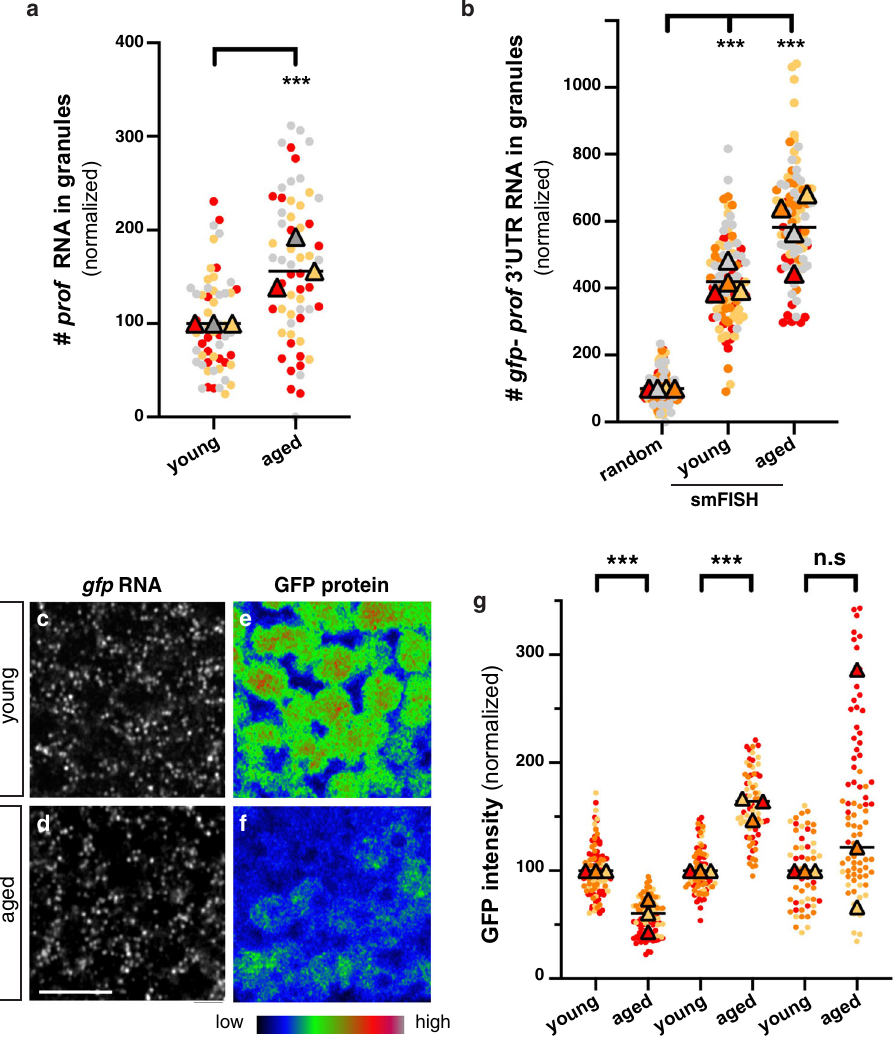
Fig. 7 Age-dependent decrease in the translation of granule-associated mRNA species. a Fraction of endogenous pro fi lin RNA molecules found in Me31B-GFP + granules of 1 – 2 day- (young) and 37 – 38 day- (aged) old fl ies. Values were normalized to the young condition. *** P < 0.001 (unpaired, two- sided t -test). b Fraction of gfp-pro fi lin 3 ’ UTR RNA molecules found in Me31B-mTomato + granules of 1 – 2 day- (young) and 37 – 38 day- (aged) old fl ies. Values were normalized to the random control, in which non-speci fi c levels of co-localization were assessed after rotating smFISH images by 90°. *** P < 0.001 (one-way ANOVA with Dunn ’ s multiple comparison tests). In a , b , the fraction of smFISH spots co-localizing with Me31B + granules was estimated for each imaged fi eld using the JACoP plugin of Fiji (see Method). Three to four replicates were performed and the mean value of each is indicated as a triangle. Data points were color-coded based on the replicate they belong to. At least 16 fi elds were imaged per condition. c – f Cell bodies of MB γ neurons expressing gfp-pro fi lin 3 ’ UTR transcripts in 1 – 2 day- ( c , e ; young) or 37 – 38 day- ( d , f ; aged) old brains. smFISH signals obtained using gfp probes are shown in c , d . GFP signals are shown in e , f . Images in e , f were color-coded using the Rainbow RGB visualization mode of Fiji. Scale bar: 5 μ